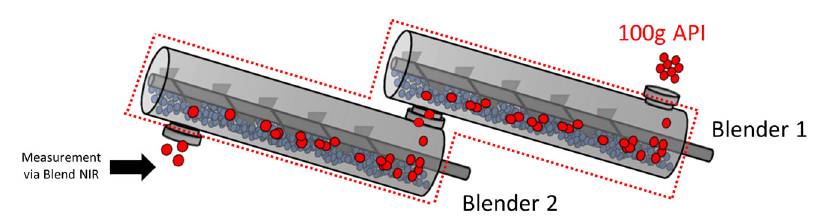
Figure 3. Graphical Representation of a Blender 1 Impulse Experiment.